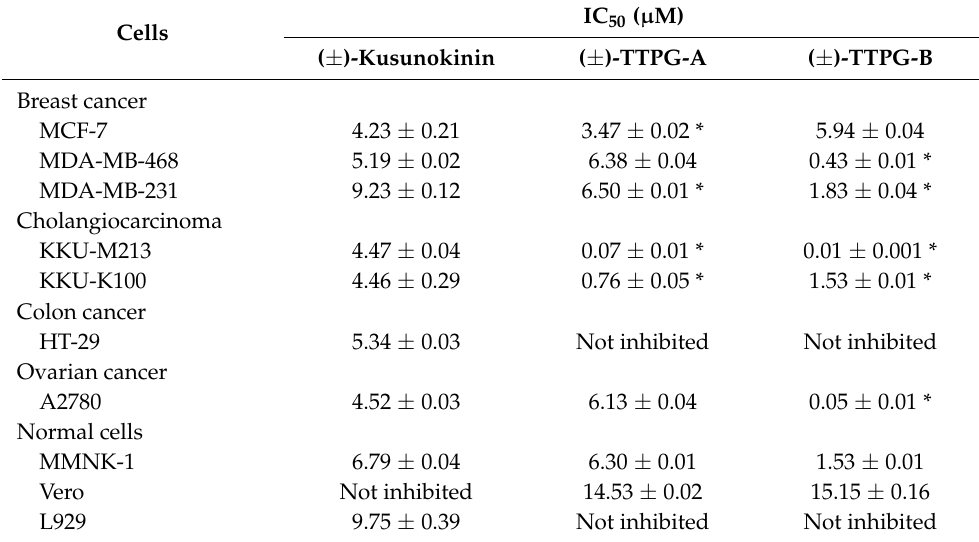
Table 1. The half-maximal-inhibitory-concentration (IC 50 ) values of ( ± )-TTPG-A and ( ± )-TTPG-B for inhibition of viability of cancer and normal cells. IC 50 ( µ M) Cells ( ± )-Kusunokinin ( ± )-TTPG-B Breast cancer